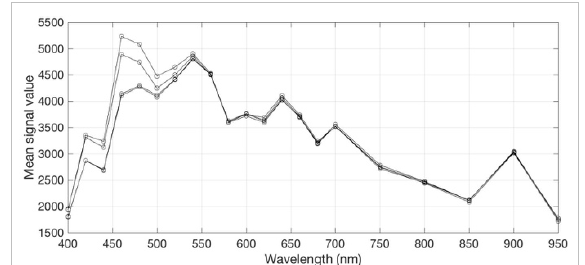
Figure 4. Mean signal value of 100 pixels averaged based on 2x2 pixel grid. This data has not yet been corrected for the luminous power or the filter sensitivity. The figure shows a difference in spectral response between 400 and 550 nm.